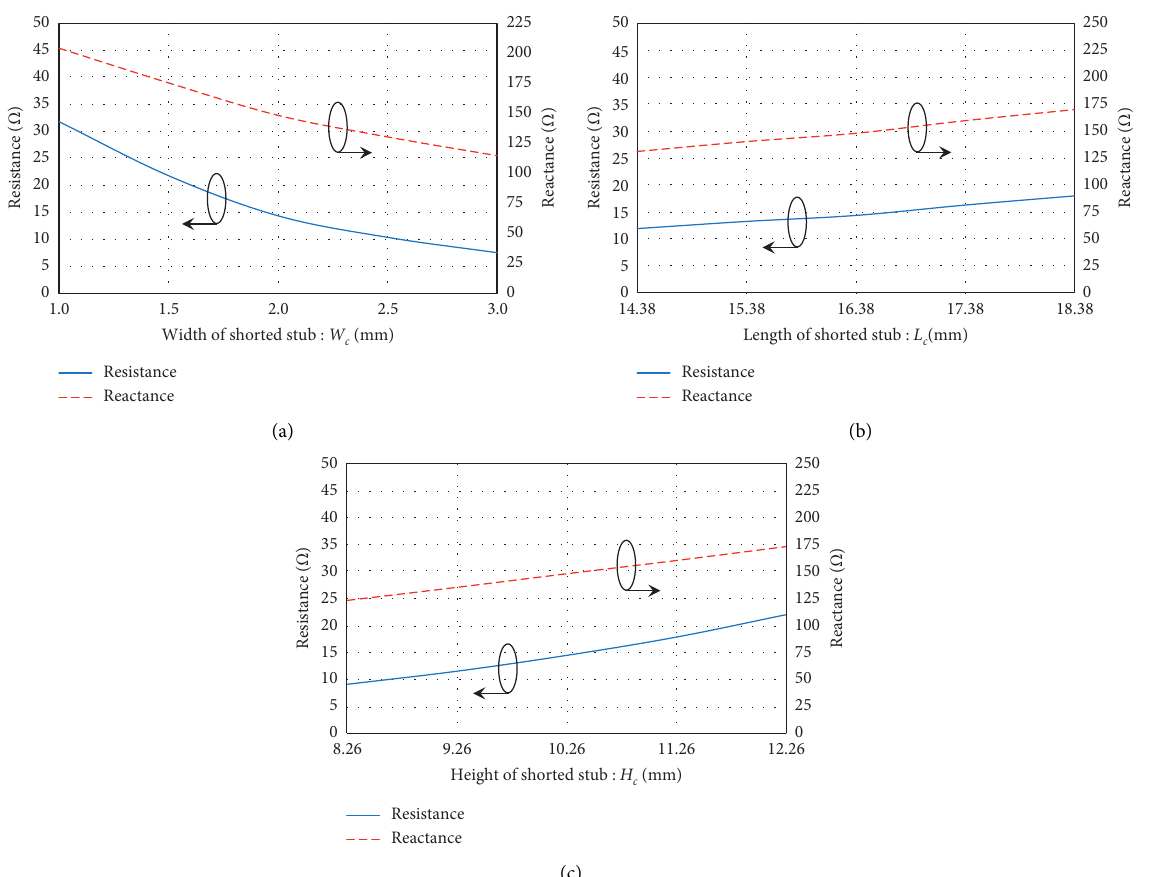
Figure 9: The simulated impedance of UHF-RFID tag antenna under varying (a) W